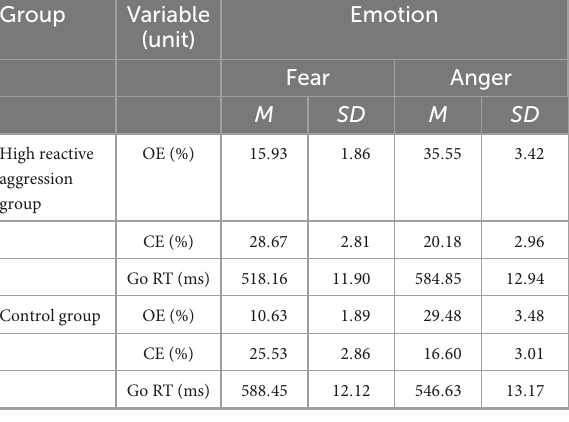
TABLE 1 Behavioral results for the emotional Go/No-Go task by the group. Group Variable